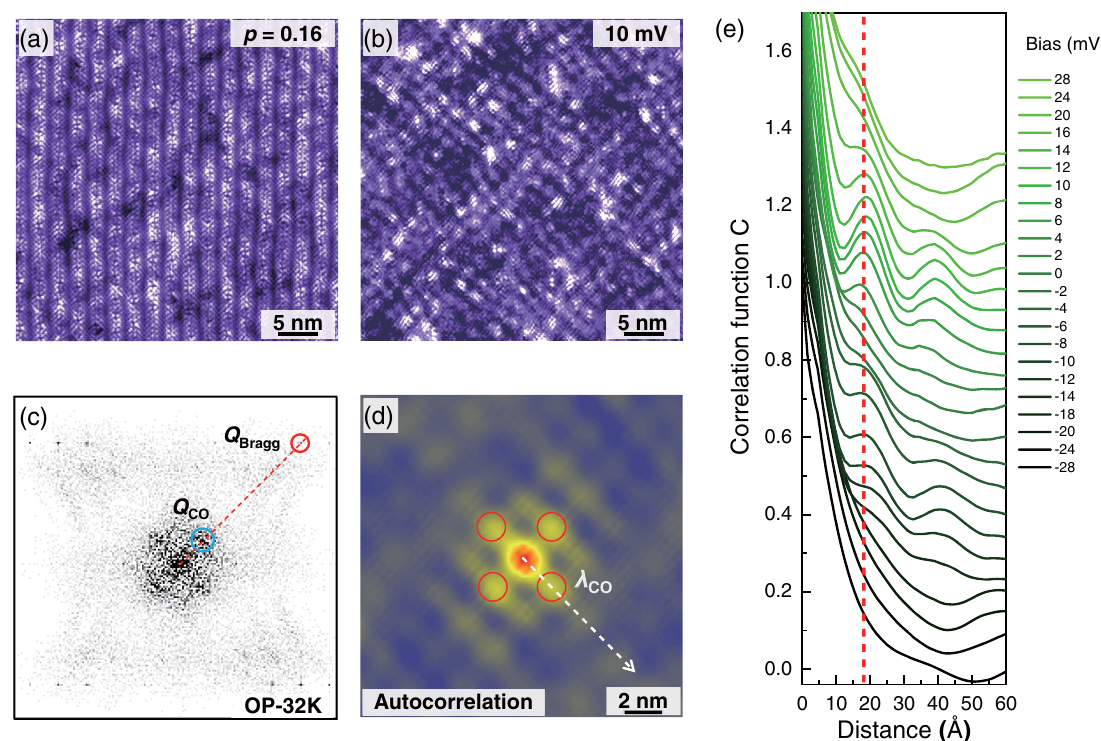
FIG. 1. The optimally doped Bi-2201 sample with p ¼ 0 . 16 . (a) Atomically resolved topographic image acquired at bias voltage V ¼ − 80 mV and tunneling current I ¼ 5 pA over an area of 400 × 400 Å 2 . (b) The dI=dV map measured in the same area as (a) at bias voltage V ¼ 10 mV and tunneling current I ¼ 20 pA. (c) The Fourier transform map of (b), where the lattice Bragg peaks are marked by red circles and the Cu ─ O bond direction is indicated by a red dashed line. The blue circle highlights the wave vector of the checkerboard charge order. (d) The autocorrelation map of (b) exhibiting a long-range checkerboard charge order, and the four red circles indicate the distance between neighboring charge puddles. The white dashed line indicates the Cu ─ O bond direction, along which the autocorrelation intensity linecut is acquired. (e) Bias-dependent autocorrelation intensity AC ð R Þ linecuts. The red dashed line indicates the position of the charge order peak, which is nondispersive over a wide range of